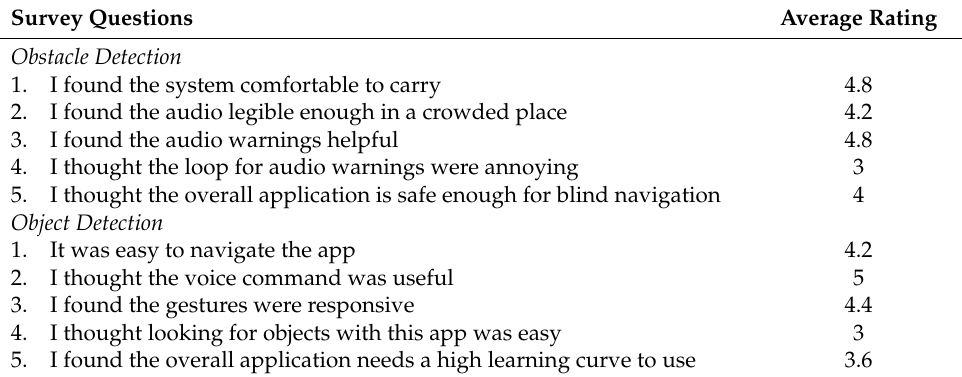
Table 6. Overall usability experience of the mobile